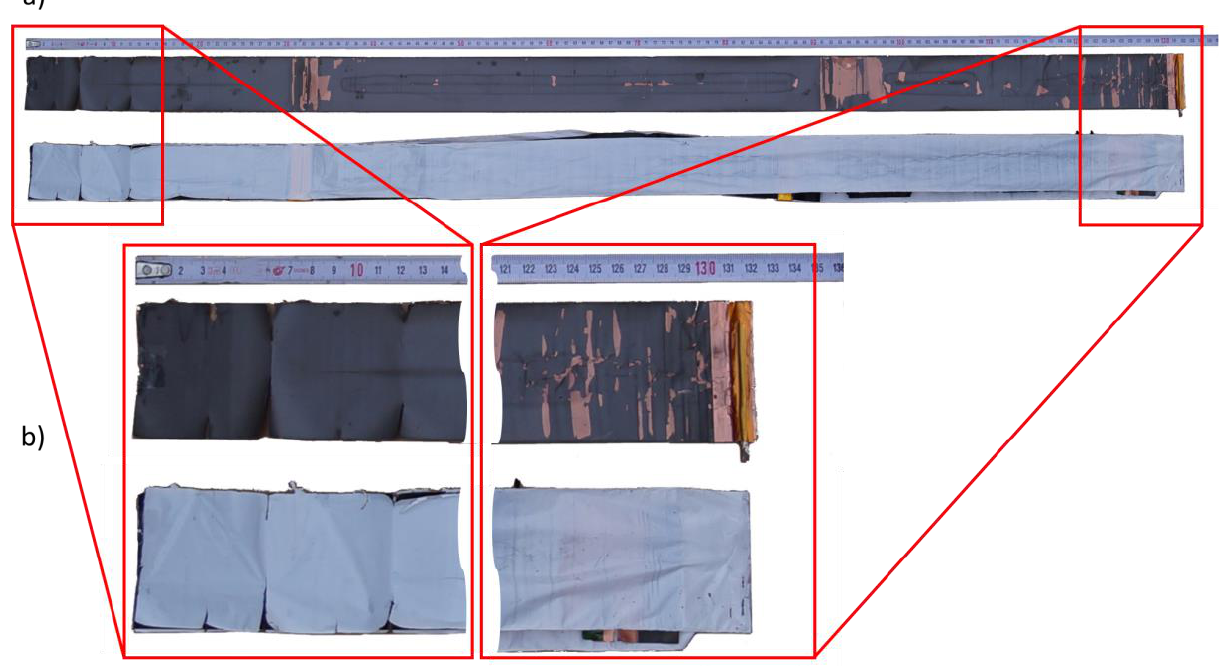
Figure 3. Disassembled cylindrical 21700 cell. Inner parts consist of anode, cathode, and separator.